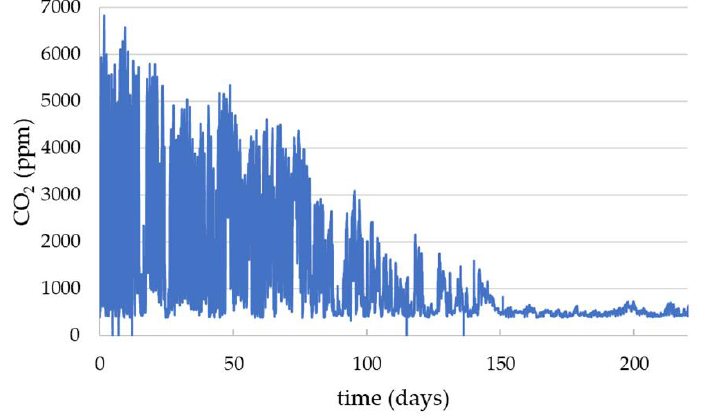
Figure 7. HPP8 crown board CO 2 data from 8 July 2022 to 14 February 2023. Inspections found that this colony was healthy at the start of the period and was observed as failed at around 150